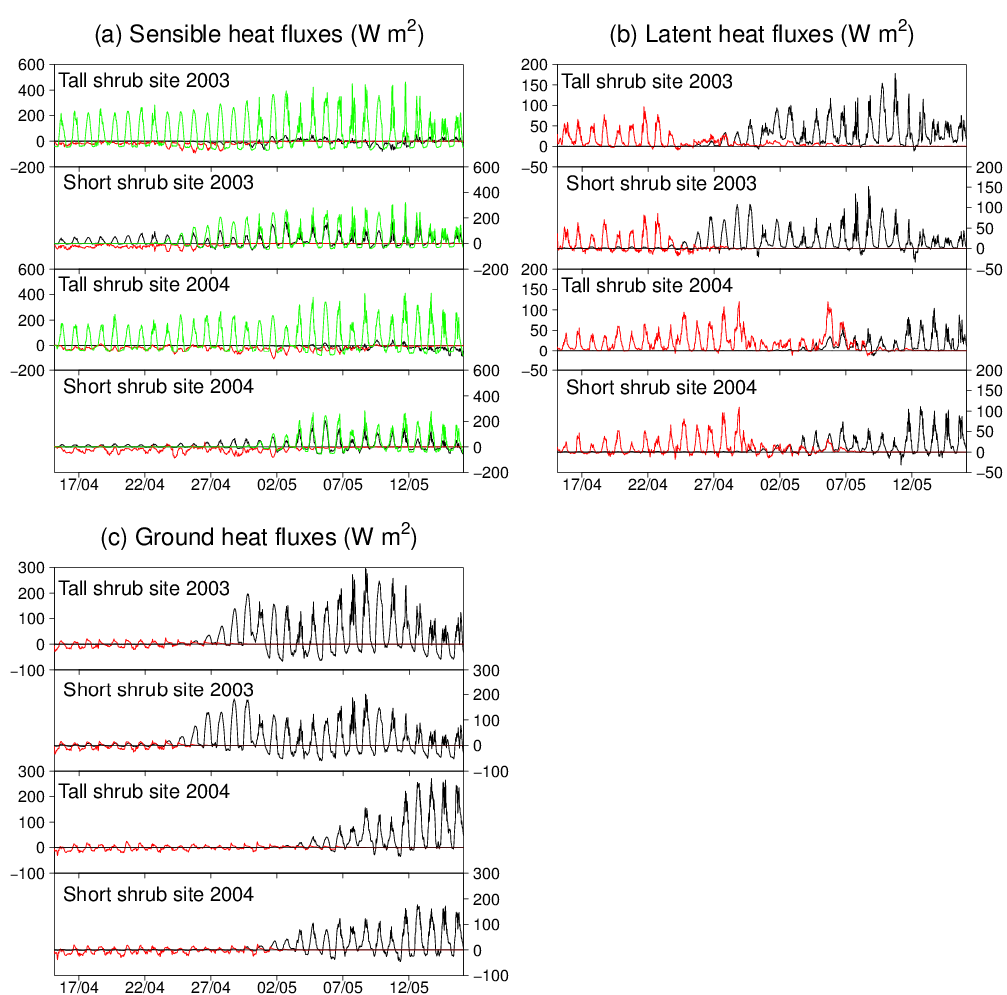
Figure 4. Modelled (a) sensible heat fluxes, (b) latent heat fluxes and (c) ground heat fluxes over individual sources (black=ground, red=snow, green=shrub) at the tall and short shrub sites in 2003 and